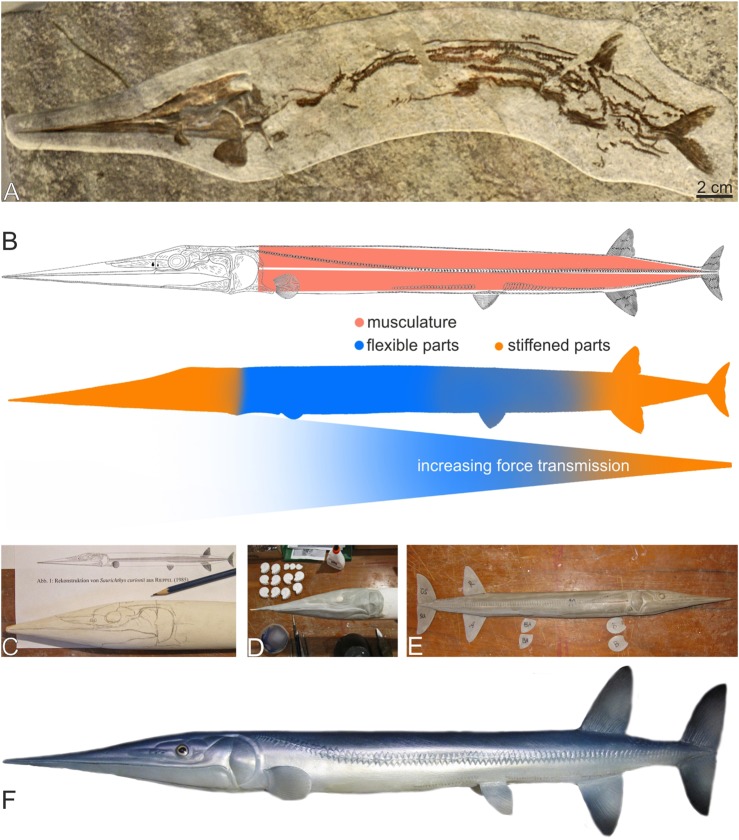
Steps of plastic rebuilding of a generalised Saurichthys. (A) a Middle Triassic Saurichthys curionii (Bellotti, 1857) from Monte San Giorgio, Switzerland; (B) presumed distribution of muscles, soft and stiffened regions, based on Rieppel's (1985) reconstruction of S. curionii; (C) sketch of the cranial elements on a model of Saurichthys head; (D) modelling of the snout and head structures; (E) application of paired fins; (F) completed Saurichthys plastic model.